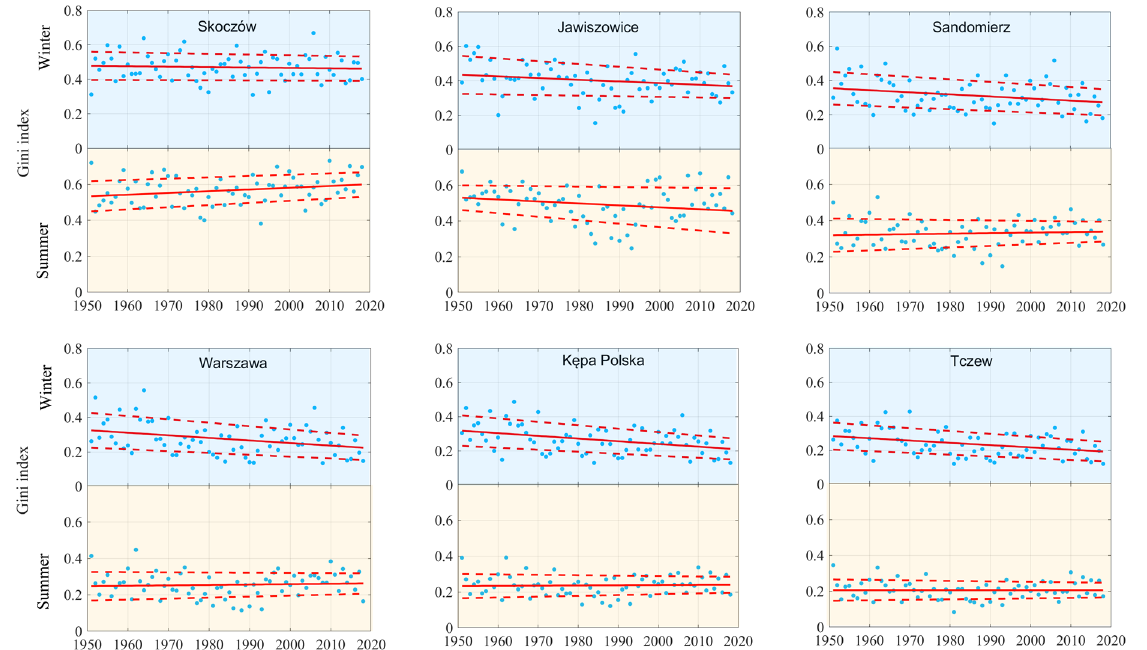
Figure 7. The linear trends in the mean and the standard deviation of the seasonal Gini index for selected stations along the Vistula.